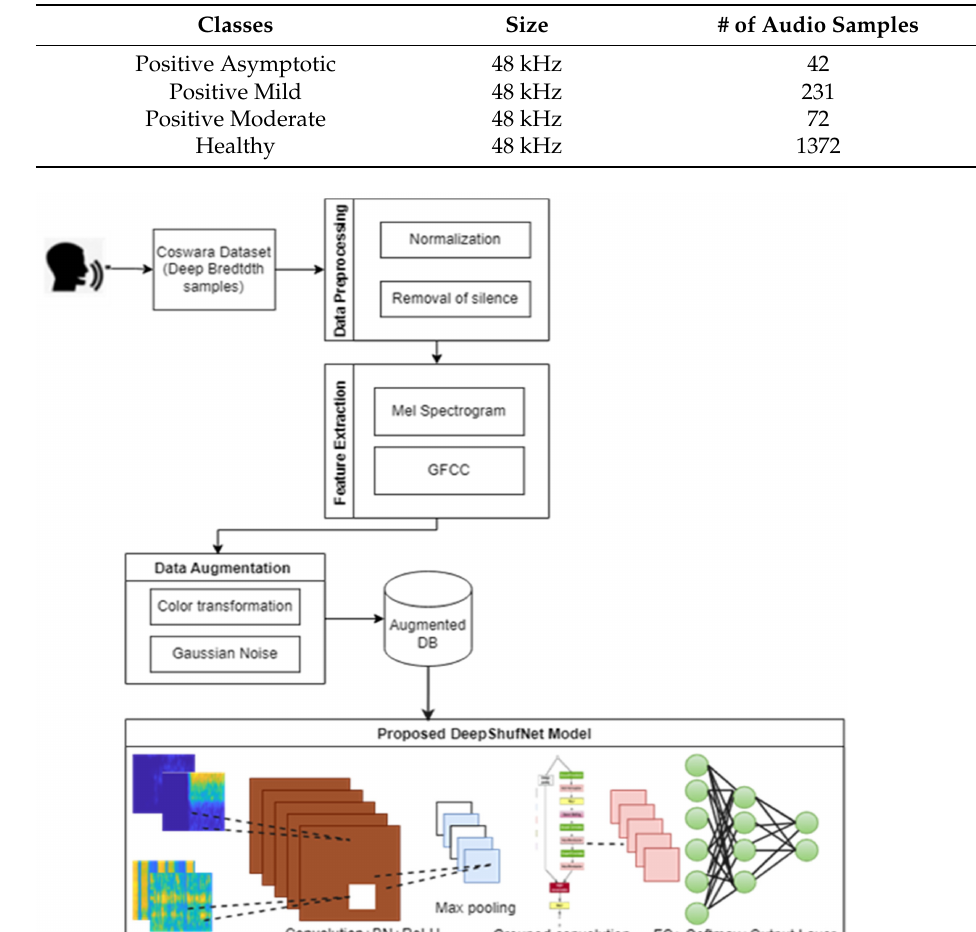
Figure 1. Summary of classes in Coswara Dataset. Table 1. Summary of the selected audio recordings for this study.